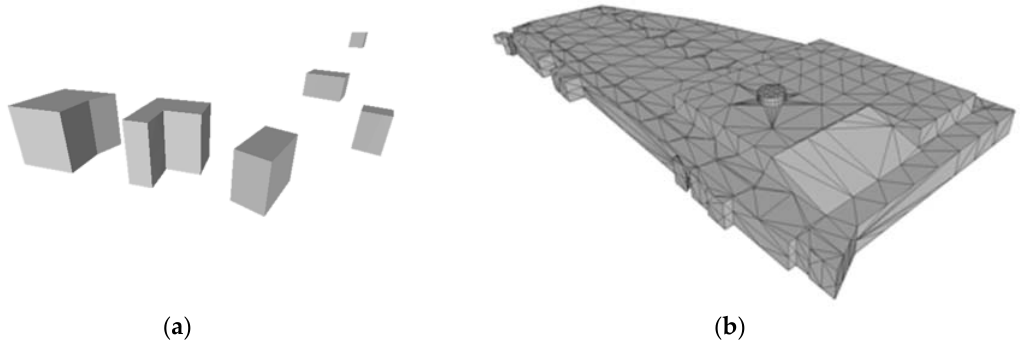
Figure 13. Examples of legal volumes in the Delft case: ( a ) seven different sub volumes forming one legal volume; ( b ) one complex legal volume that has been triangulated.